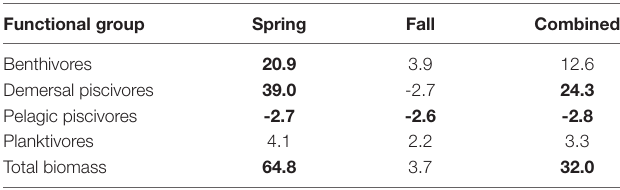
TABLE 4 | Theil–Sen slope estimates expressed in decadal rates of change for CPUE variables by functional groups. Functional group Spring Fall Combined